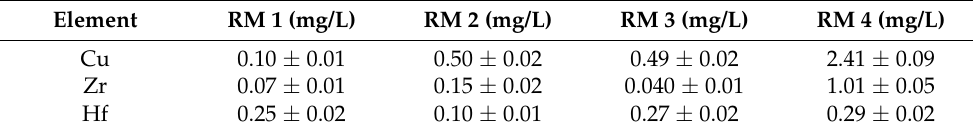
Table 3. The certified concentrations of the RMs (m RM = 0.05 g, V solution = 10 mL). Element